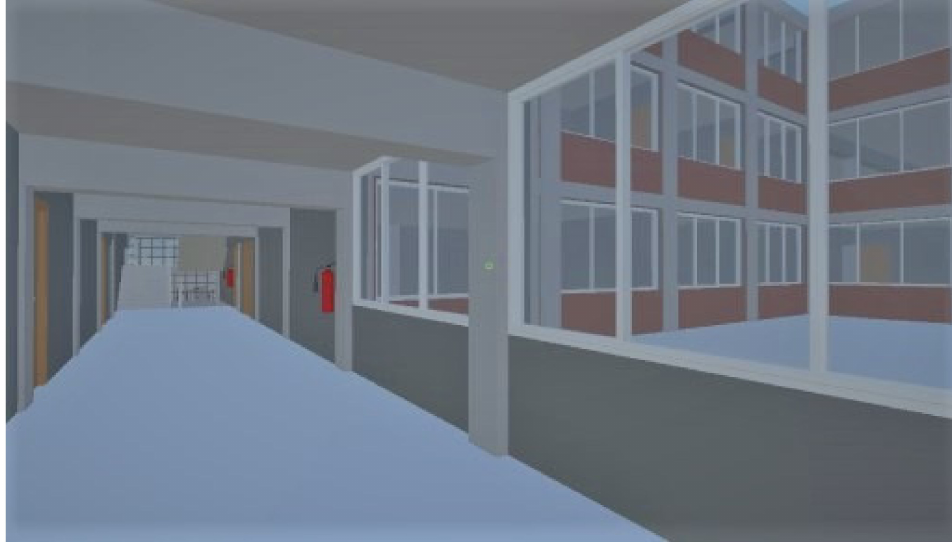
Figure 4. Building Engineering Faculty of the University of La Laguna created with Unity 3D: http://playa.joseluissaorin.com accessed on 18 November